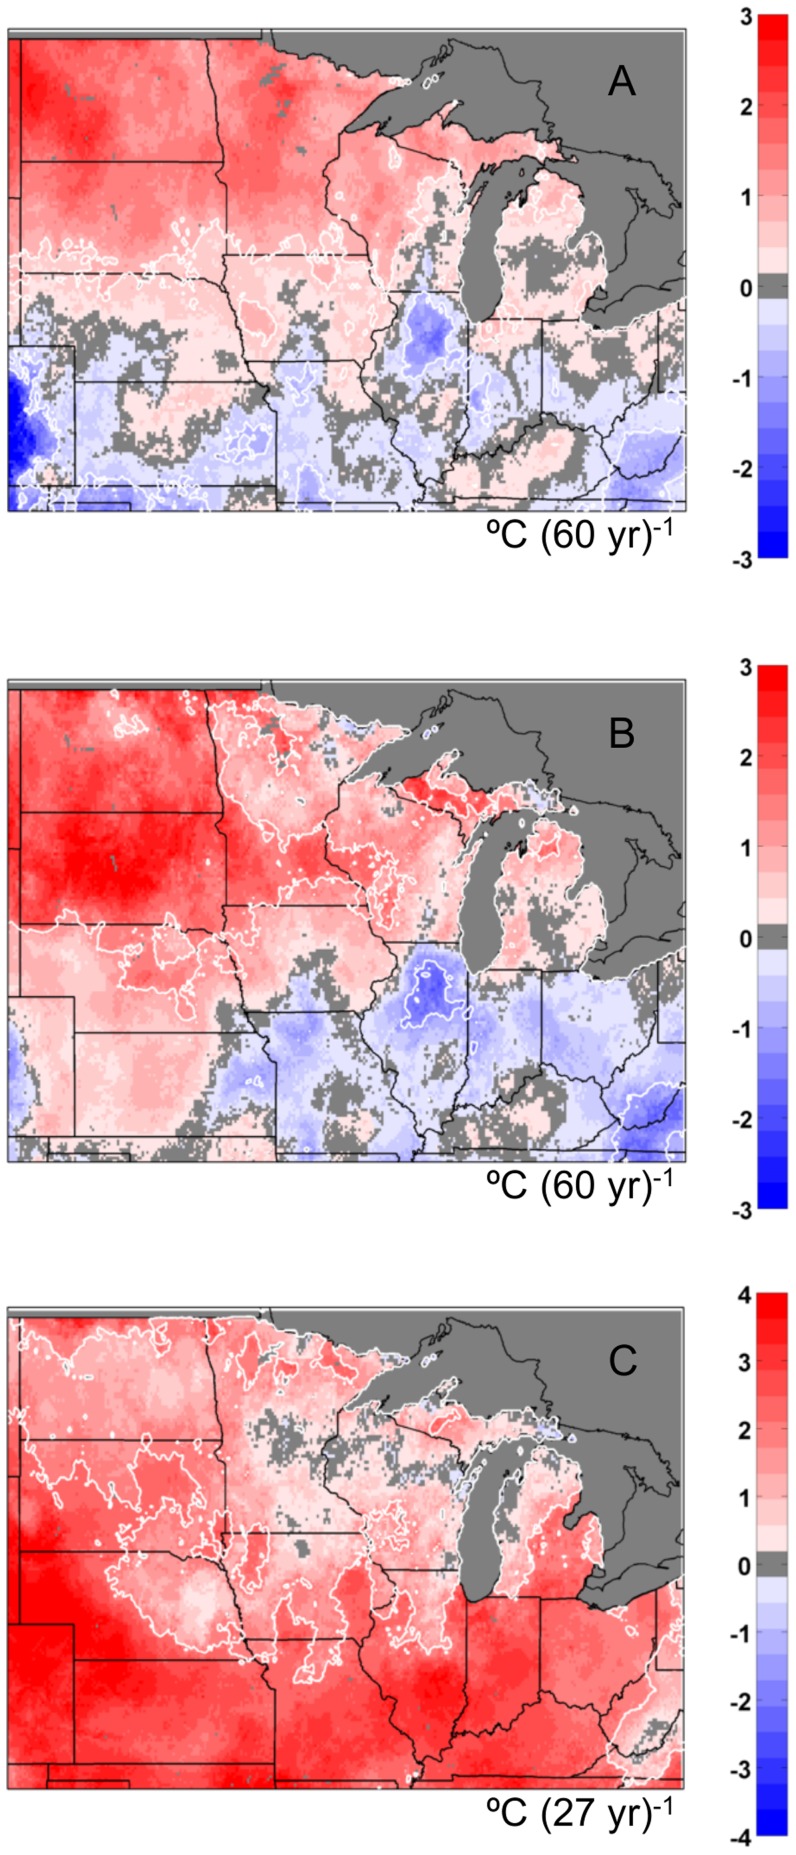
Simulated soil temperature trends across the Midwest US.(a) Total change (from linear regression) in annual average 10 cm soil temperatures for 1948–2007 for the MAIZE+TILL (bare soil) simulation; (b) total change (from linear regression) in annual extreme minimum 10 cm soil temperature for the MAIZE+TILL (bare soil) simulation from 1948–2007; (c) total change (from linear regression) in annual extreme minimum 10 cm soil temperature for the MAIZE+TILL (bare soil) simulation from 1981–2007. Regions bounded by solid white lines indicate trends with P<0.05.